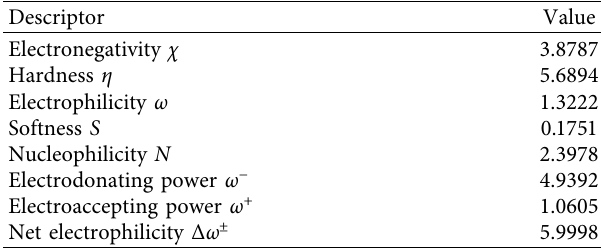
Table 4: Global reactivity descriptors for the alternaramide marine cyclopentadepsipeptide (all in